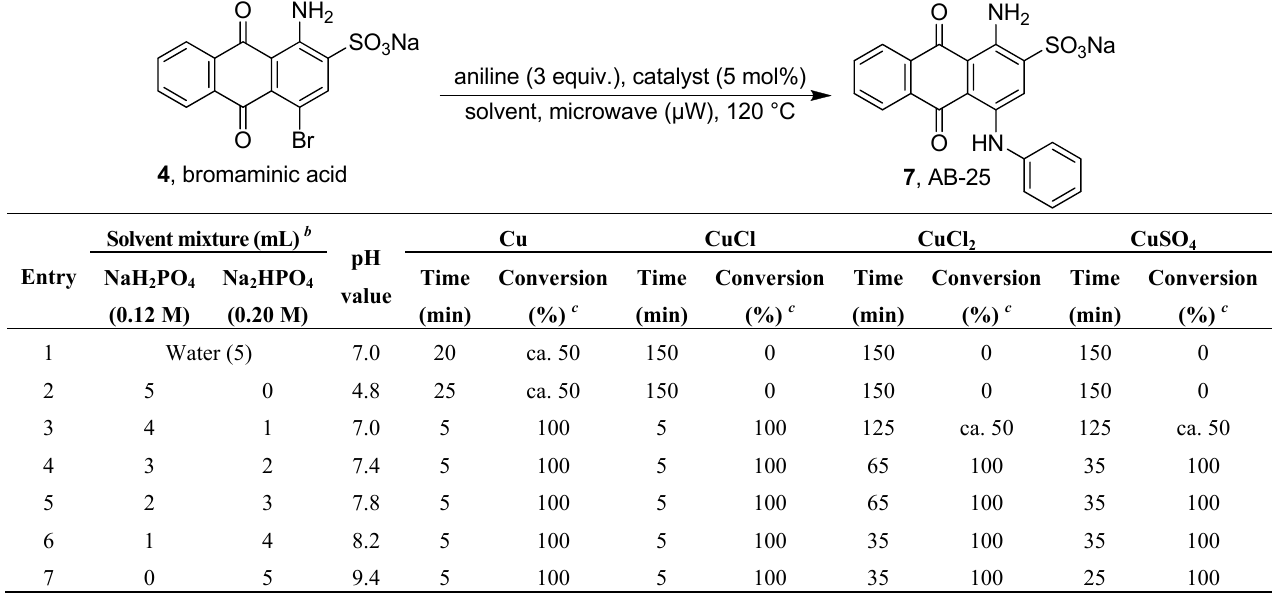
Table 1. Impact of different pH values on the synthesis of AB-25 in the presence of a copper catalyst. a